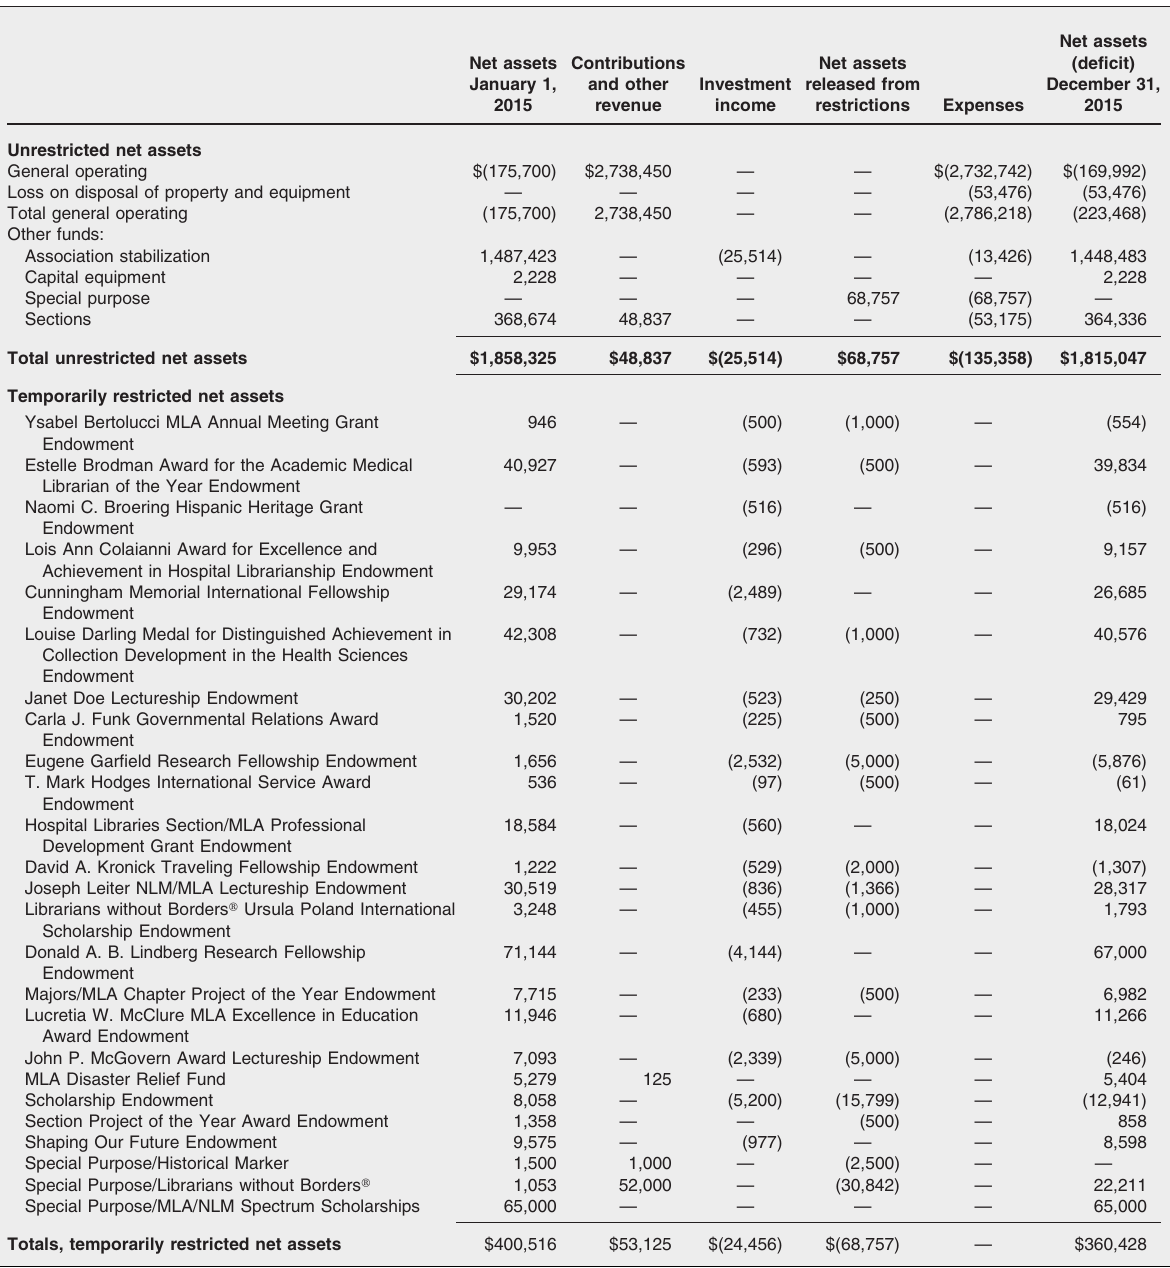
Medical Library Association schedule of changes in net assets by fund year ended December 31, 2015